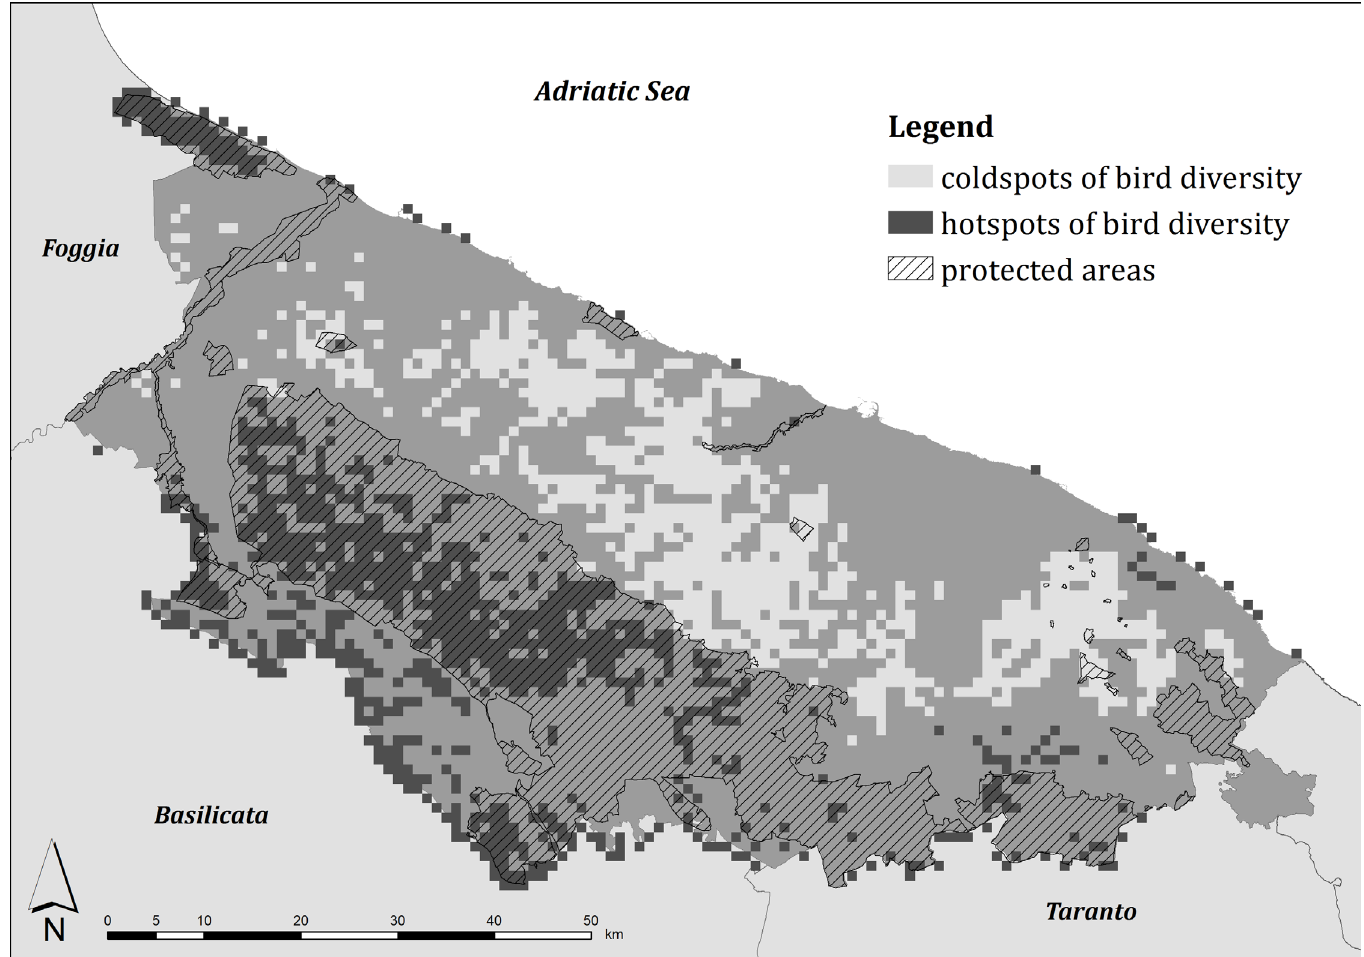
Fig 3. Breeding hotspots of bird diversity in central Apulia and protected area